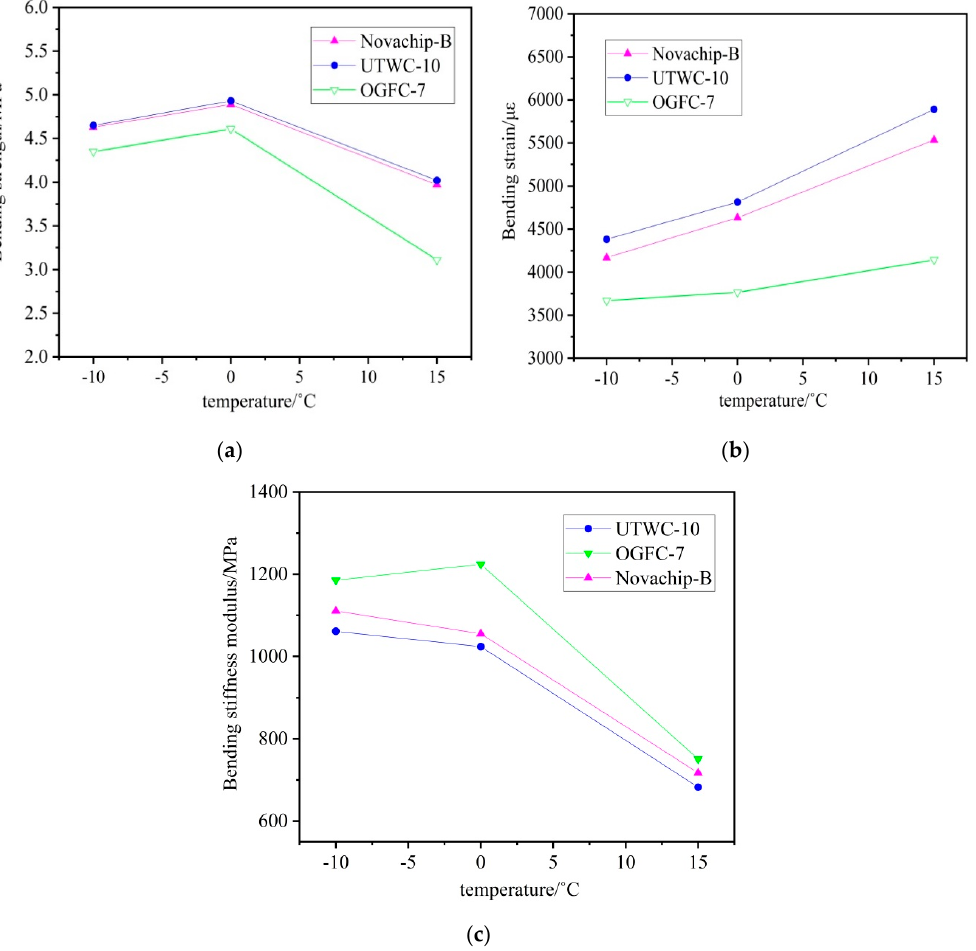
Figure 7. The various performance indexes of the three asphalt mixtures: ( a ) relationship between the bending strain and temperature; ( b ) relationship between the bending strength and temperature; and ( c ) relationship between the bending stiffness modulus and temperature.